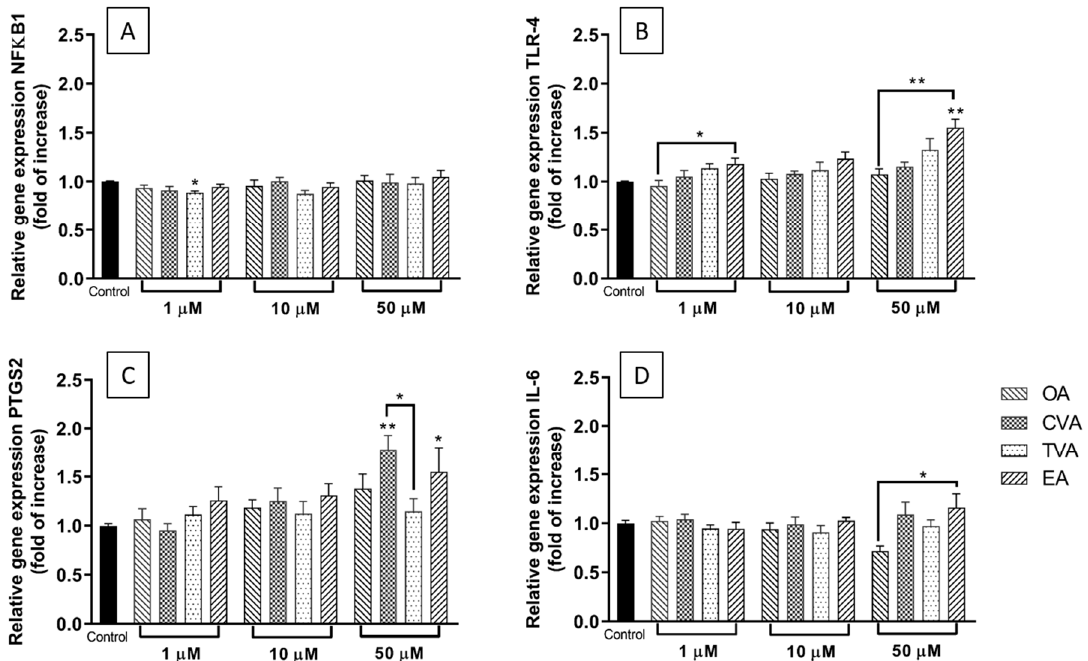
Figure 5. Expression of NF κβ 1 ( A ), TLR-4 ( B ), PTGS2 ( C ), and IL-6 ( D ) genes in EA.hy926 cells preincubated for 48 h with 1, 10, and 50 µ M of FA in DMEM containing 0.1% of ethanol (Control) followed by incubation with TNF- α (1 ng/mL) for 6 h. Cq values were normalised by the geometric mean of reference targets RPL13A and CYC1 genes. Bars are mean ± SEM of 9 samples performed in 3 experiments. Data were analysed using one-way ANOVA with Tukey’s as post hoc test. * p < 0.05, ** p < 0.01 between groups indicated by joined lines or vs. Control when there is no joined line. OA = oleic acid, CVA = cis vaccenic acid, TVA = trans vaccenic acid, EA = elaidic acid.